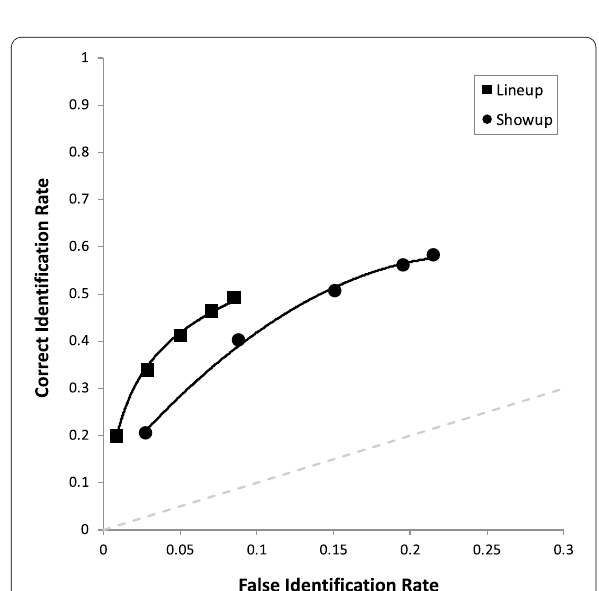
Fig. 4 ROC curve for lineups versus showups, collapsed over all other